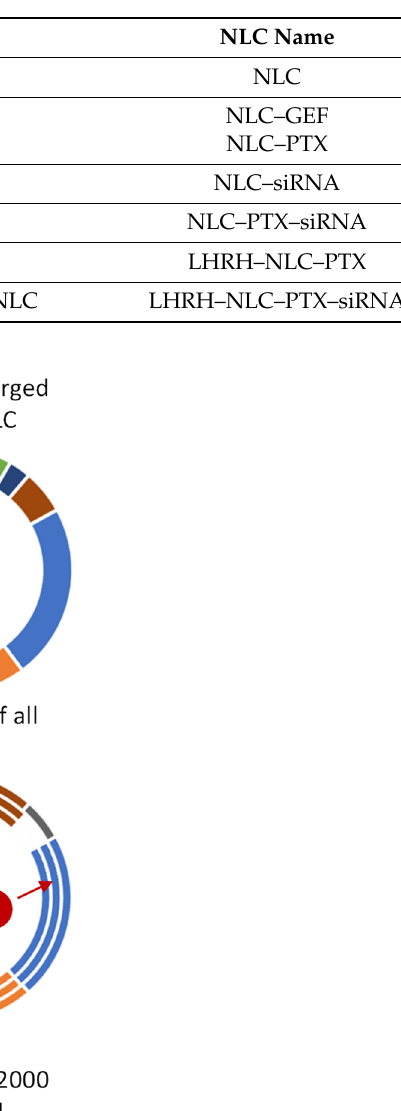
Table 1. The list of all NLC formulations.